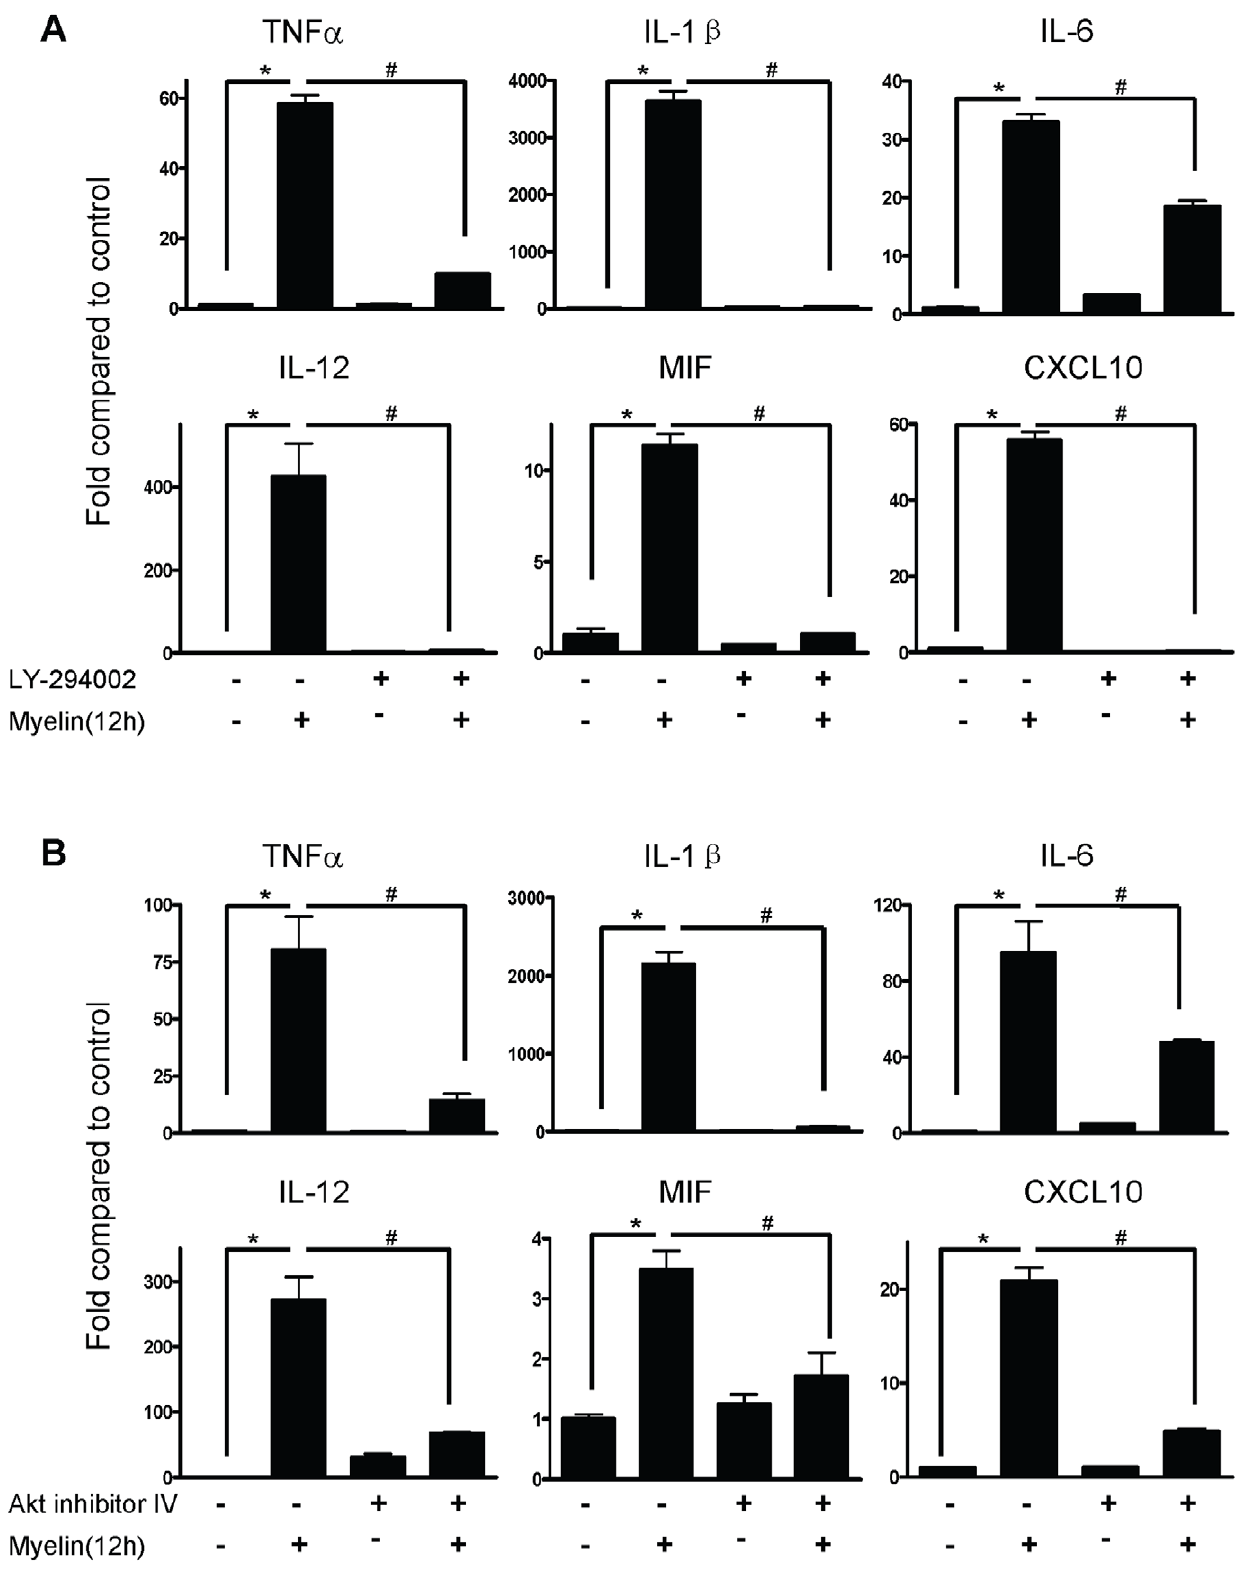
Figure 9. Effect of inactivation of PI3K and Akt on myelin-induced cytokine expression in macrophages. Macrophages were pre-treated with LY-294002 (A) or Akt inhibitor IV (B) for 30 minutes and then treated with myelin for 12 hours. Cytokines at transcriptional level were detected by qRT-PCR. Data were expressed as mean 6 SEM and similar results were obtained from three independent experiments. (n=3, *P , 0.05 vs. control; # P , 0.05 vs. inhibitor treatment; t -test).